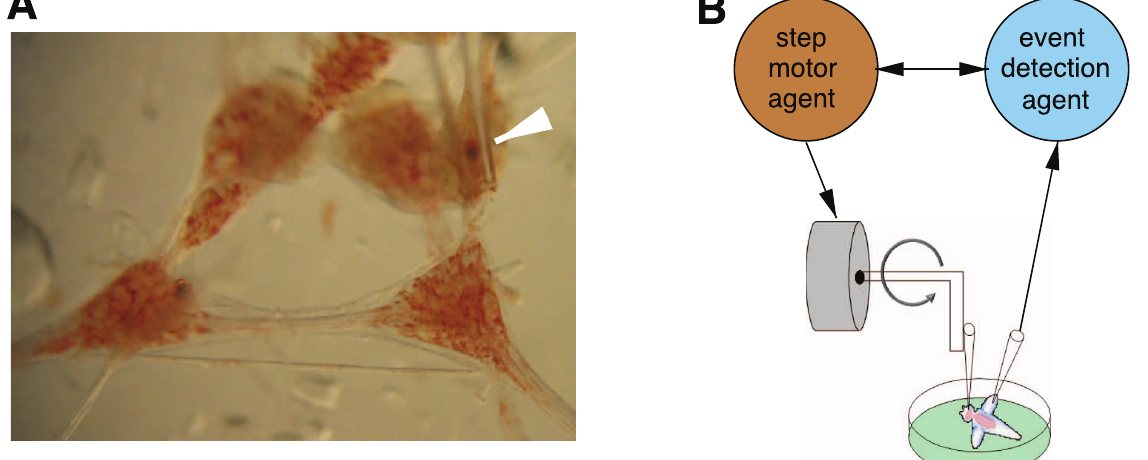
Figure 8. Experimental setup for the closed-loop mechanical stimulation. (A) Close up of the preparation showing Clione ’s nervous system with the pipette holding the statocyst (white arrow). (B) Schematic representation of the activity-dependent mechanical stimulation closed-loop. The figure depicts the suction pipette that holds the gravimetric organ and the recording electrodes used to detect events that drive the motor movements.